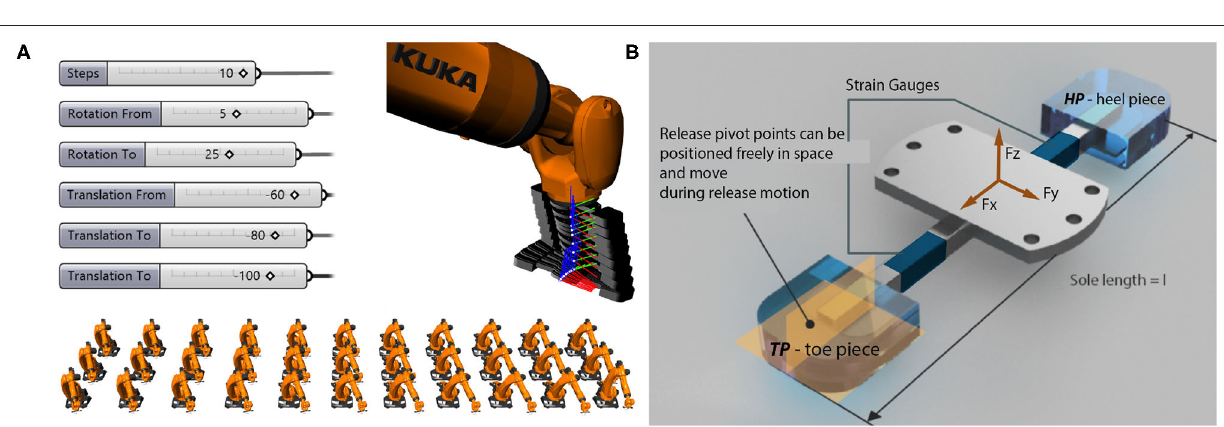
bigger the load applied to the ski. F z ,